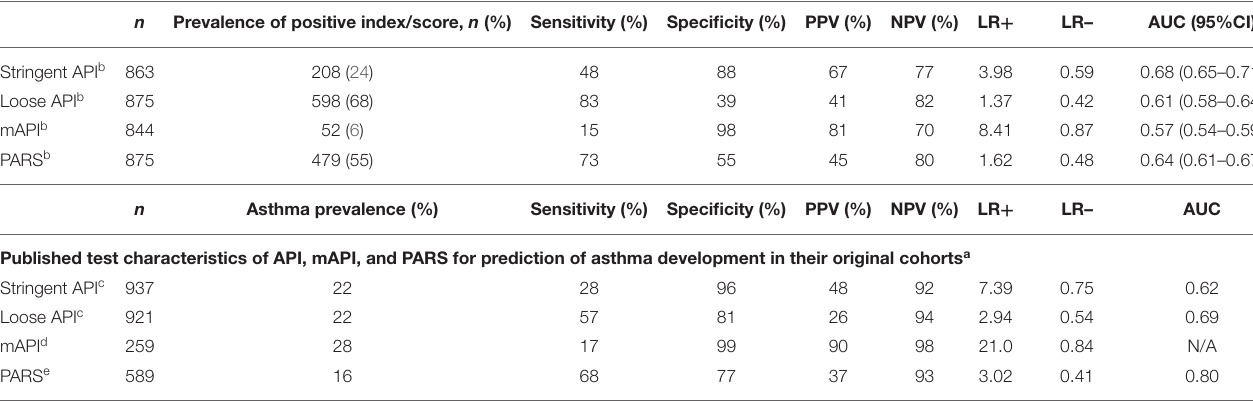
TABLE 2 | Performance of API, mAPI, and PARS in predicting asthma development among children hospitalized for severe bronchiolitis during infancy (MARC-35 cohort) and in their original cohorts a